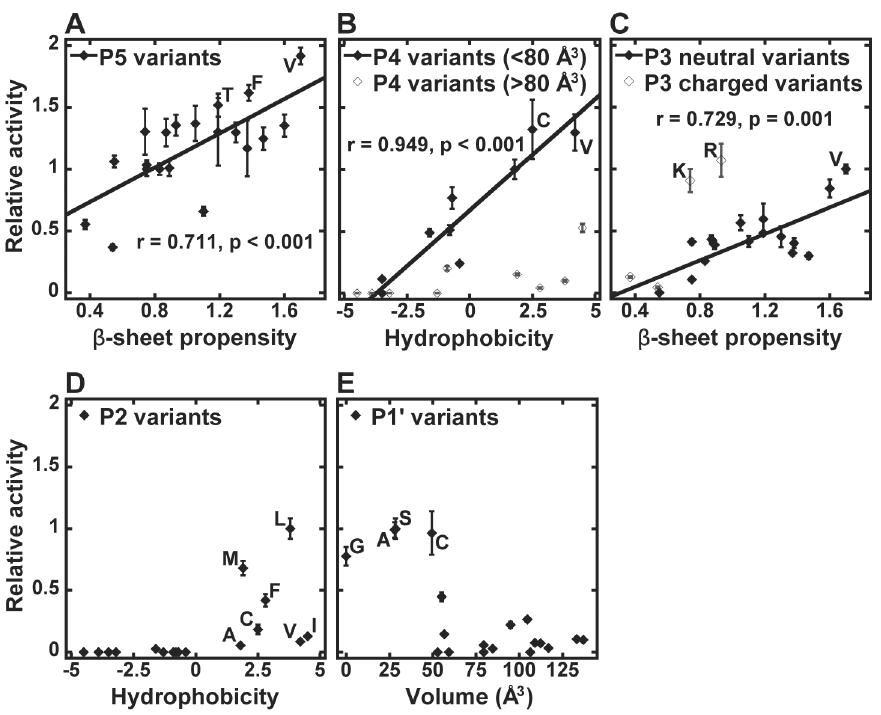
Figure 3. Substrate specificity for SARS-CoV 3CL pro . The relative activity significantly correlated with various structural properties of substituting residues. (A) At P5 position, the relative activity correlated well with the b -sheet propensity (r=0.711, p , 0.001). (B) At P4 position, significant correlation was observed for hydrophobicity (r=0.587, p=0.008). The correlation was improved (r=0.942, p , 0.001) when only residues with side chain volumes of , 80 A˚ 3 (Ala, Asn, Asp, Cys, Glu, Gly, Pro, Ser, Thr and Val) were included. (C) The relative activity on P3 variants were correlated with b -sheet propensity (r=0.510, p=0.022). Increase in the correlation (r=0.729, p=0.001) was found after neglecting charged residues (Arg, Asp, Glu and Lys). (D) Only variants with hydrophobic residues (Ala, Cys, Ile, Leu, Met, Phe, and Val) at P2 position were cleavable. (E) The relative activity on P1’ variants with side chain volume of , 50 A˚ 3 (Ala, Cys, Gly and Ser) were higher than that on others. doi:10.1371/journal.pone.0013197.g003 PLoS ONE |